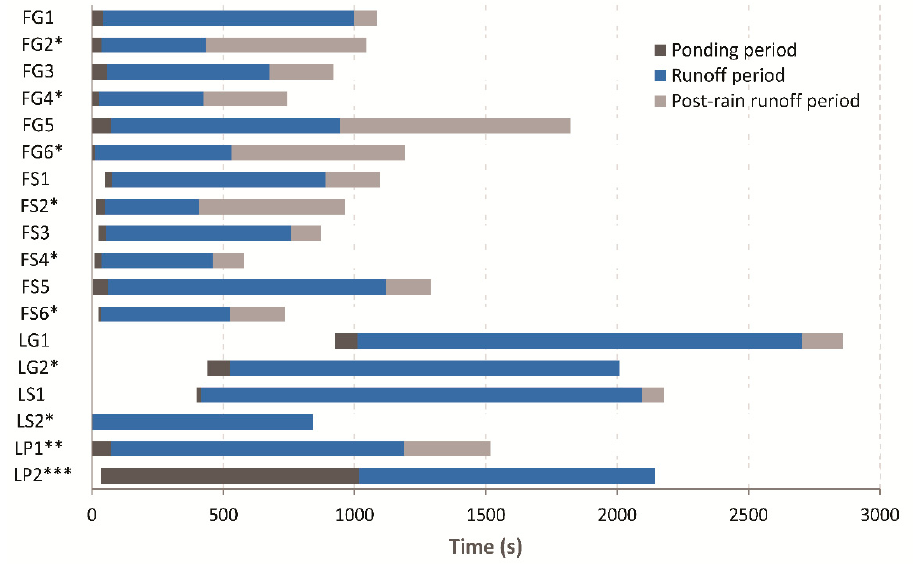
Figure 3. Durations of the ponding, runoff, and post-rain runoff periods at the field and laboratory experiments. Asterisks refer to * crusted, ** wet, and *** dry surface conditions. F—field, L—laboratory; P—plain (2% slope); G—gentle slope; S—steep slope; for details, see Table 2.